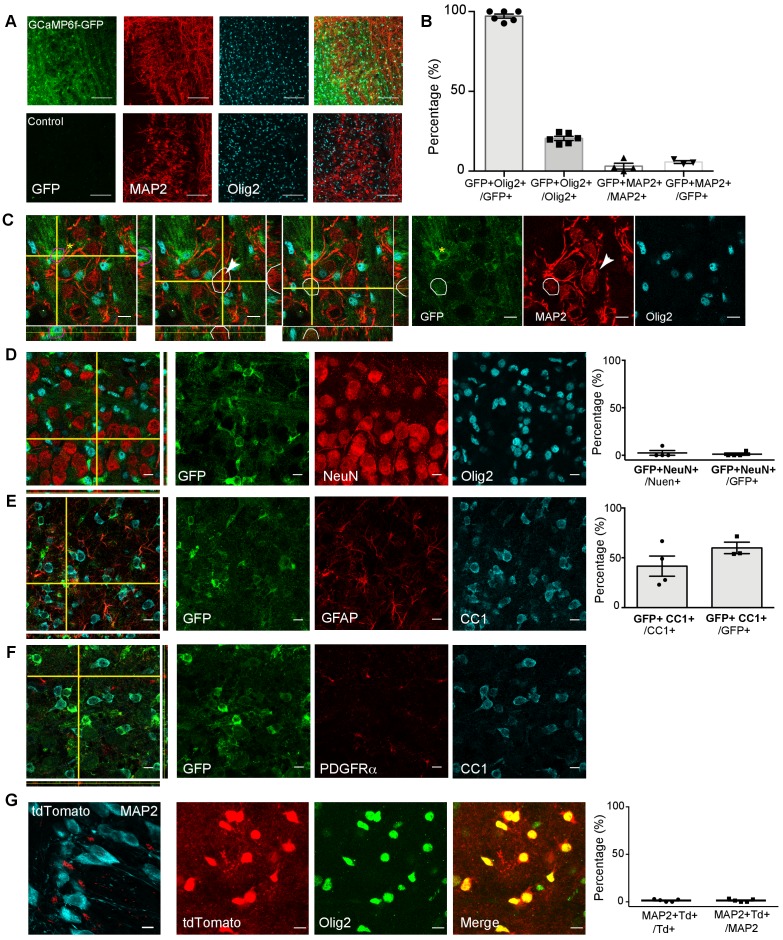
The specificity of the Cnpcre line.(A) Cnpcre driven GFP-tagged GCaMP6f in Cnpcre:GCaMP6f-GFP+ mice (GFP) demonstrates expression in OLs. Upper: Co-localization of GFP with neuronal marker (MAP2) and OL marker (Olig2) in 20x image (z projection, 20 μm). Lower: Negative control, No GFP is seen in negative control (Cnpcre: GCaMP6f-GFP– mice). (B) Summary of GFP+ cell population, which are co-localized with Olig2 and MAP2. Cnpcre driven GFP is found in a subpopulation of Olig2+ OL (GFP+Olig2+/Olig2+ = 20.5 ± 3.2%) and a minimal number of MAP2+ neurons (GFP+ MAP2+/MAP2+ = 3.1 ± 3.6%). It indicates that CNP+ cells are approximately 20% of total OL lineage cells in this brain region and are not neuron. Quantification of GFP+ expression shows indicates the majority of GFP+ cells are Olig2+ (GFP+ Olig2+/GFP+=97.2 ± 3.3%) and not MAP2+ (GFP+ MAP2+/MAP2+ = 5.6%±1.6%). Scale = 100 μm (n = 3 mice/genotype). (C) A single focal image with orthogonal views taken at 40x. GFP demonstrates GFP staining was strongly detected around Olig2+ nuclei (red circle in the first panel). However, GFP signal was not detected from MAP2+ cell (white circle in the second panel). There is no detectable co-localization with GFP and MAP2 staining. One potentially GFP+ MAP2+ cell is observed with very dim GFP intensity (white outline in the third panel). Yellow star and white arrowhead indicate GFP+ cell and MAP2+ neuron, which were analyzed. Scale = 10 μm. (D) Image of NeuN+ cell with orthogonal views (63x, left). GFP signal was co-localized with Olig2, but not with another neuronal marker, NeuN (middle). Scale = 10 μm. Quantification of GFP+ cell population of total NeuN+ cells, showing that a minority of GFP+ cells are NeuN+ (GFP+ NeuN+ /GFP+ = 1.2% ± 2.4%) with very small number of potentially positive neurons (GFP+ NeuN+ /NeuN+ = 2.5 ± 5. 0 %, n = 3 mice). (E) Image of GFP+ cell with orthogonal views (green, 63x, left). GFP was co-localized with CC1 (mature oligodendrocytes) but not with GFAP (marker for astrocytes). No GFP was observed in astrocytes. Scale = 10 μm. 41.6 ± 20.1% of CC1+ OL expressed GFP and 60.0 ± 9.9% GFP+ cells were CC1+ (n = 3 mice). (F) Image of PDGFRα+ cell with orthogonal views (red, 63x, left). GFP was co-localized with CC1 (mature oligodendrocytes) but not with PDGFRα (OL progenitor cells, OPC). No GFP was observed in PDGFRα+ cells. (G) Cnpcre driven tdTomato demonstrates tdTomato is not observed in neurons. Quantification analysis shows majority of tdTomato+ cells are not MAP2+ (tdTomato+ MAP2+/MAP2+ = 1.4 ± 0.6% and tdTomato+ MAP2+/tdTomato+=1.4 ± 0.6%). tdTomato+ cells were positive to Olig2, indicating tdTomato+ cells are oligodendrocytes. All data are shown as mean ± s.d.